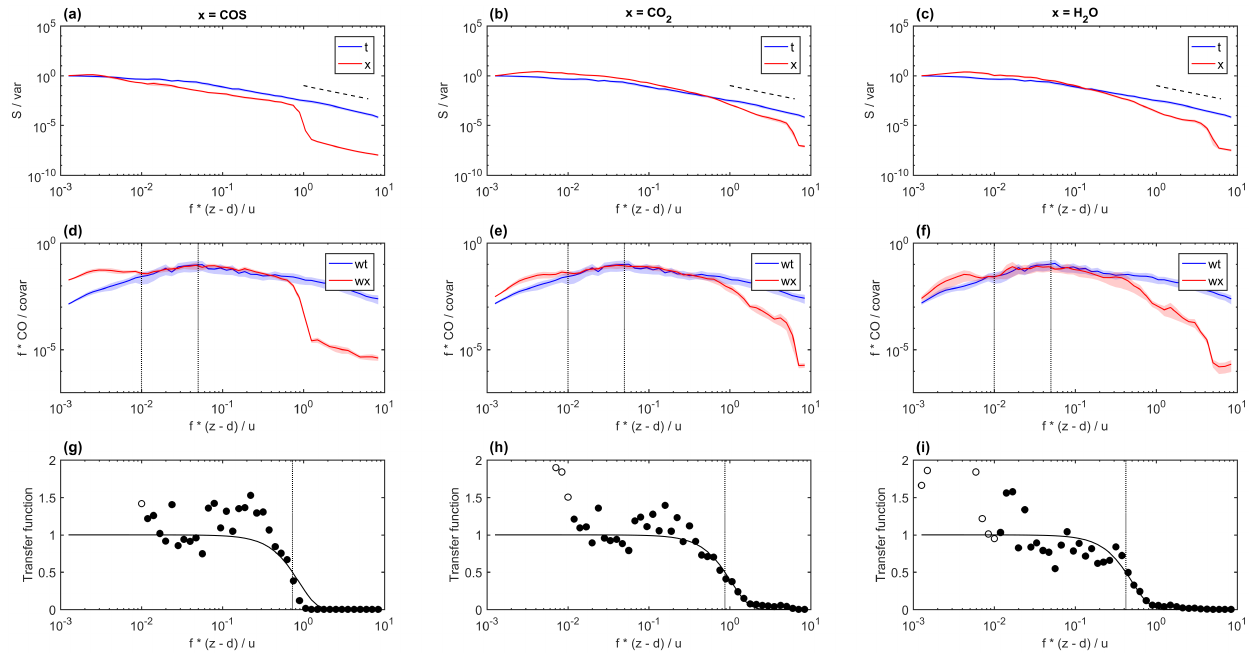
Figure 3. Spectra (a, b, c) and cospectra (d, e, f) for temperature (referred to as t and wt) and COS (a, d, g) , CO 2 (b, e, h) and H 2 O (c, f, i) (referred to as x and wx , with x representing the three scalars). Spectra (S) and cospectra (CO) were normalised by their variance (var) and covariance (covar), respectively. The natural frequency ( f ) was normalised by the measurement height above the zero-plane displacement height ( z – d ) and the mean horizontal wind speed ( u ). Solid lines and shaded areas refer to the average and 1 standard error. Data were filtered for unstable conditions ( z/L < − 0.25) and wind speeds between 1.00 and 1.25ms − 1 . The dashed line in the upper panel indicates the expected − 5 / 3 decay in the inertial subrange. Vertical dotted lines in the middle panel encompass the frequencies between which cospectra were normalised to each other. The lower panels show experimental transfer functions as the ratio of the normalised COS, CO 2 and H 2 O to temperature cospectra. Vertical dotted lines in the lower panels indicate the half-point frequency. Only data indicated by closed symbols in the lower panels were used to estimate the half-point frequency.